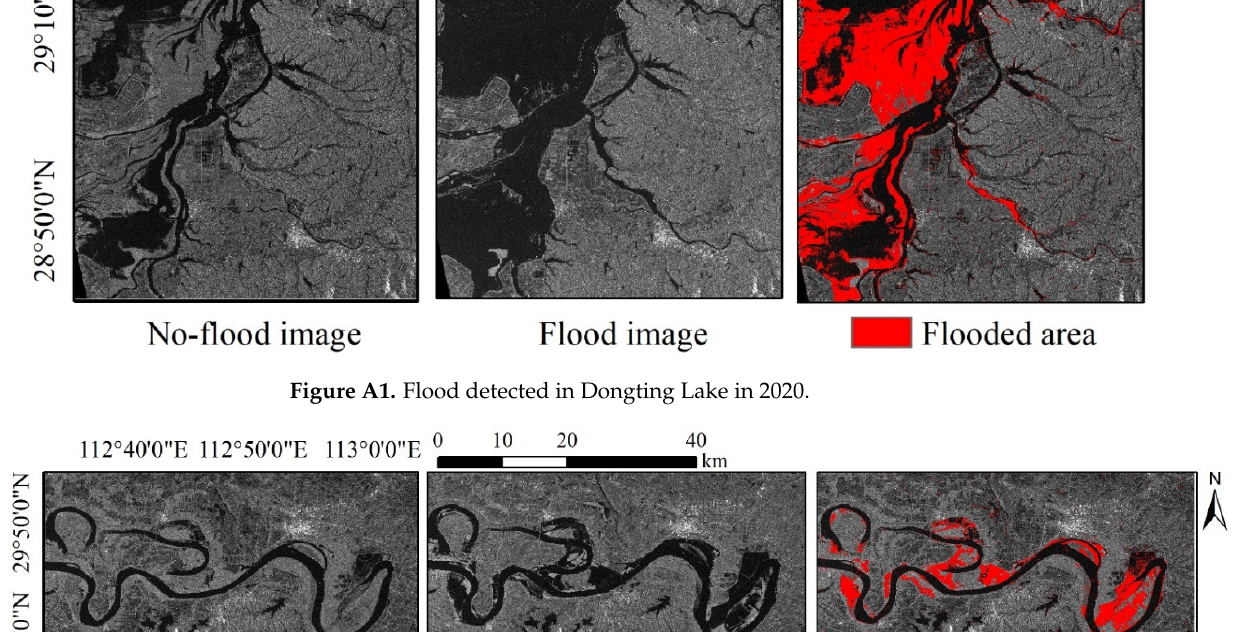
Figure A3. Flood detected in Shengjin Lake in 2020. Figure A4. Flood detected in Xinmiao Lake in 2020. References 1.